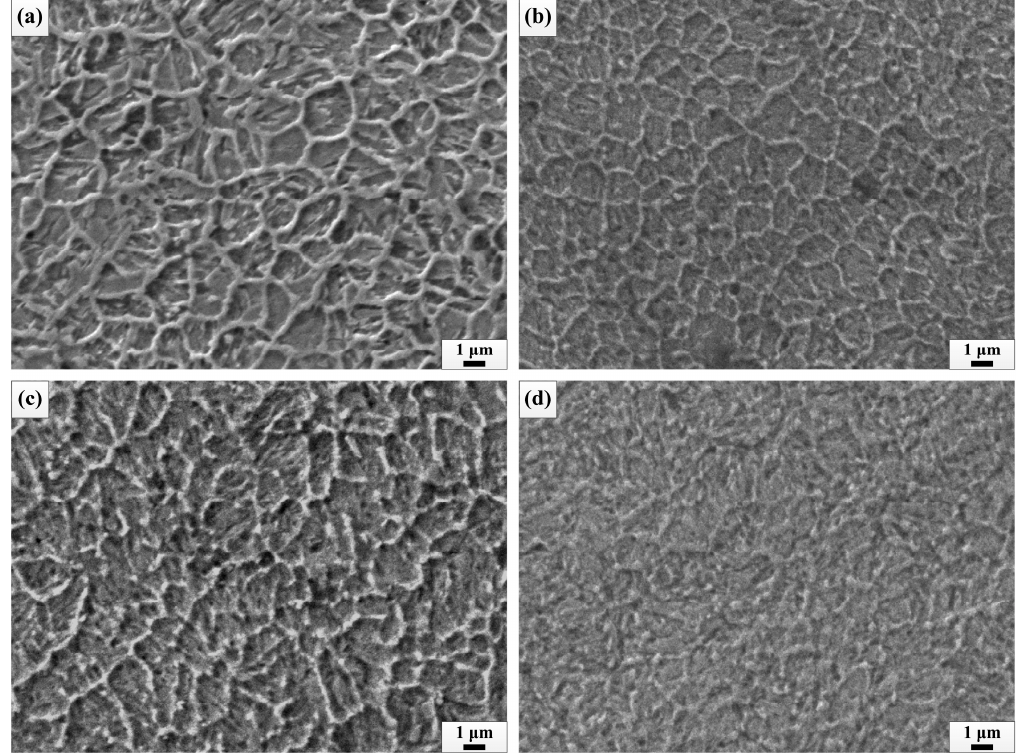
Figure 6. Microstructure evolution of laser-melted zone after different numbers of thermal fatigue cycles: ( a ) 0 cycle, ( b ) 400 cycles, ( c ) 800 cycles, and ( d ) 1200 cycles.